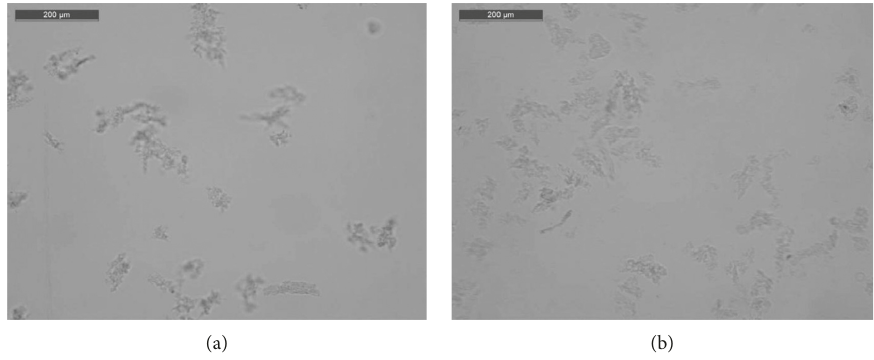
Figure 18: Hydrogels for AA/CS 5: (a) after of gelation time and (b) before of gelation